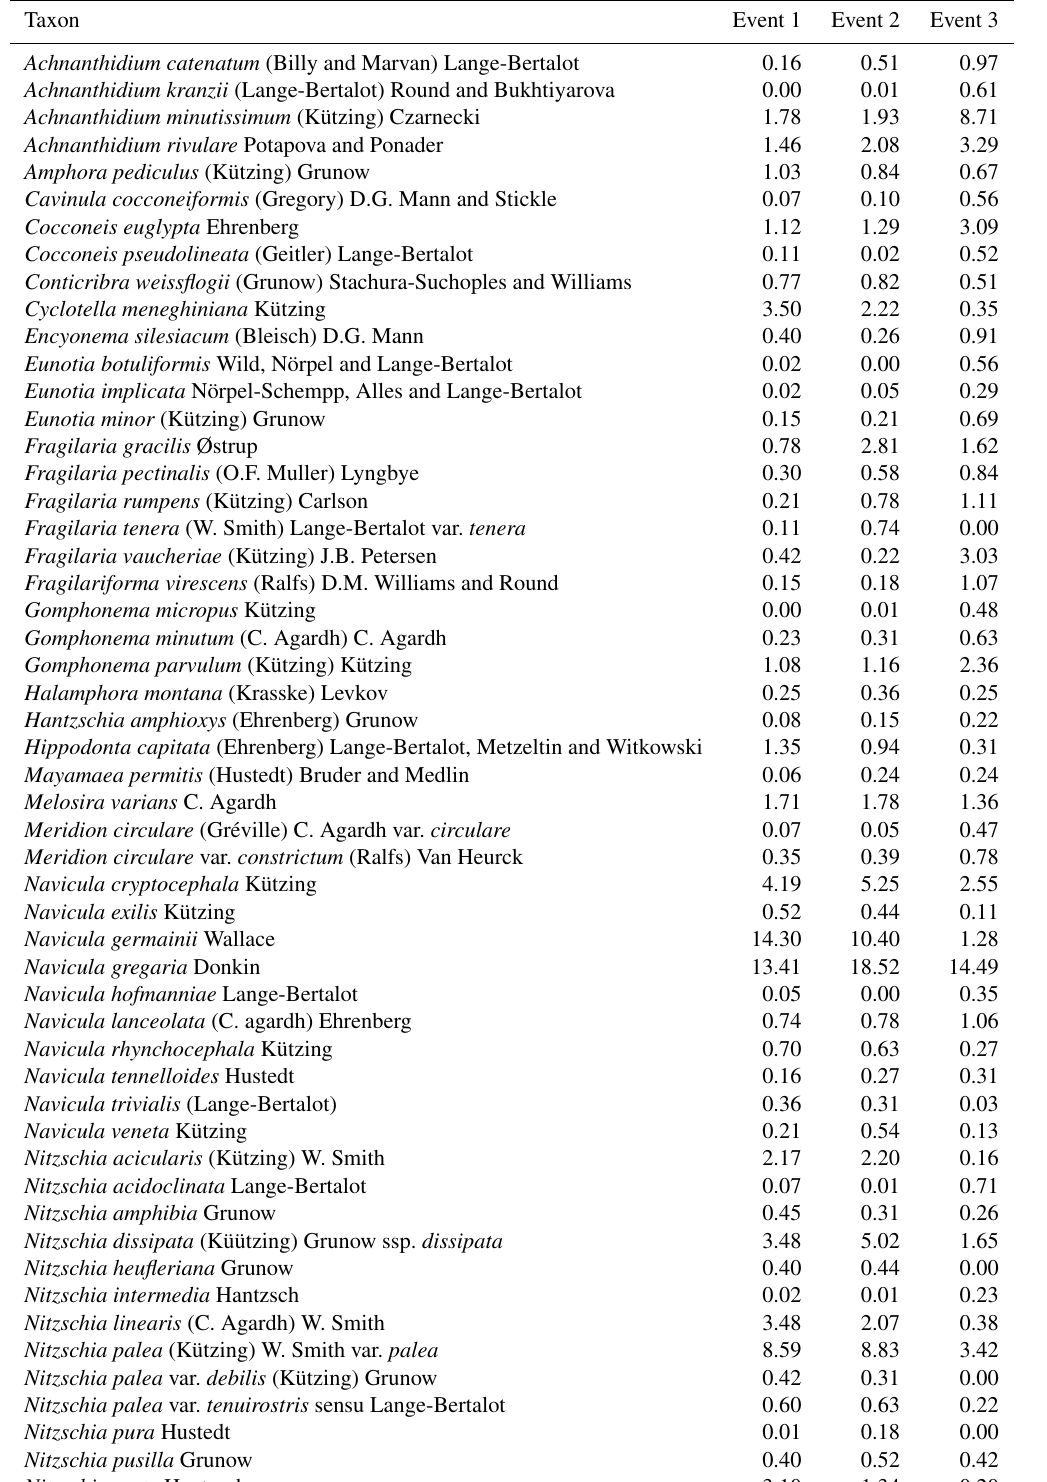
Table A1. Species list with species relative abundances (%) per event. The list only includes taxa with a relative abundance of at least 1% in a minimum of two